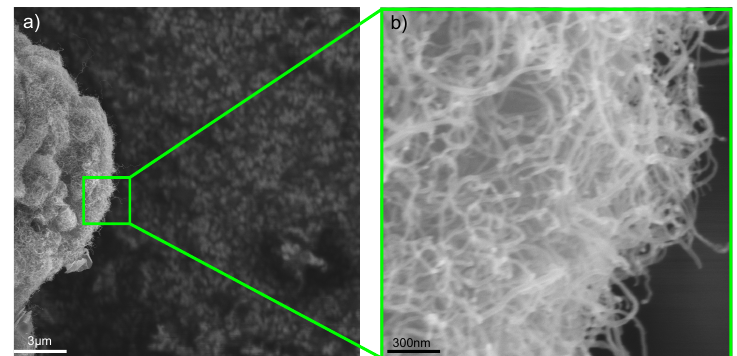
Figure A4. SEM images for CNTA at magnifications of ( a ) 10k and ( b ) 150k.